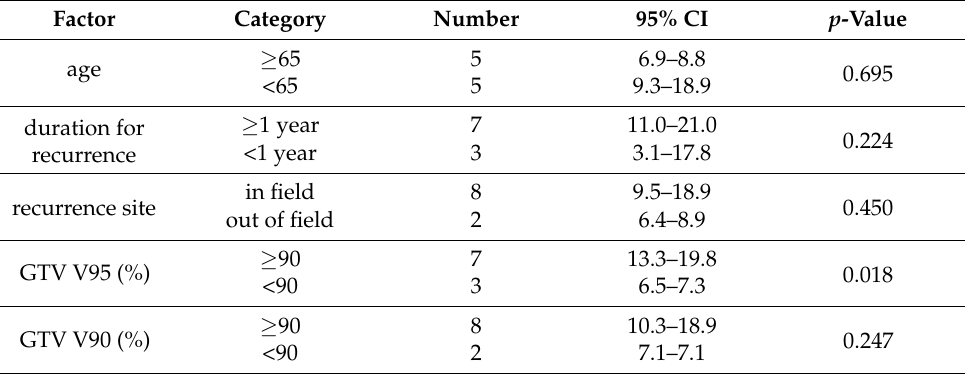
Figure 2. Survival rate after 2nd CIRT. The survival rates were calculated by using Kaplan–Meier method. OS; overall survival rate, LC; local control rate, PFS; progression free survival rate. Table 2. Univariate analysis for local recurrence after 2nd CIRT.